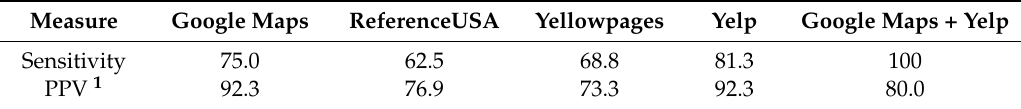
Table 1. Online sources for vape shops, Pitt County and Durham County, NC, USA, 2016. Measure Google